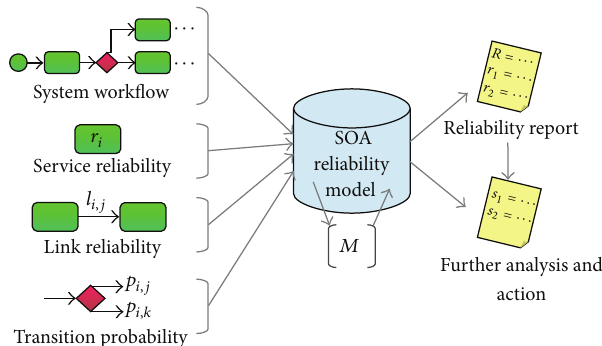
Figure 2: Framework of the